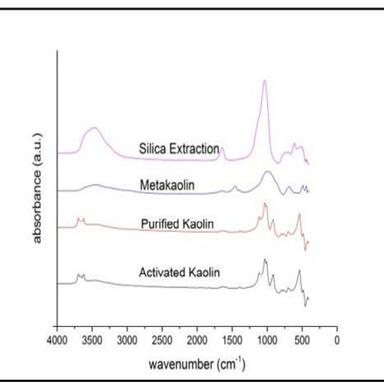
FTIR of raw materials